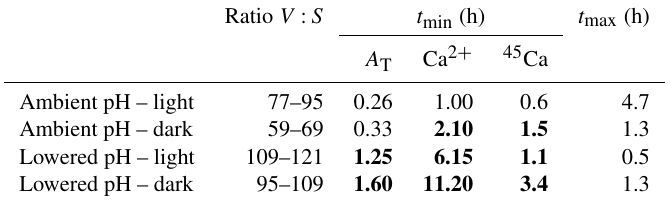
Table 5. Incubation times ( t min ; h) necessary to obtain significant signals using the three methods: the alkalinity anomaly technique ( A T ), the calcium anomaly technique (Ca 2 + ), and the 45 Ca incorporation techniques ( 45 Ca); see text for calculation procedures. t max (h) is the maximum incubation time to maintain carbonate chemistry within an acceptable range ( (cid:49) pH T < 0 . 06 and (cid:49)C T < 10% and (cid:49)A T < 10%). The ratios between incubation volume ( V , in milliliters) and the size of the nubbins ( S , in centimeters), considered in our study for the different sets of incubations (ambient pH vs. low pH; light vs. dark), are also shown. t min values are noted in bold when higher than t max . Ratio V : S t min (h) t max (h) A T Ca 2 + 45